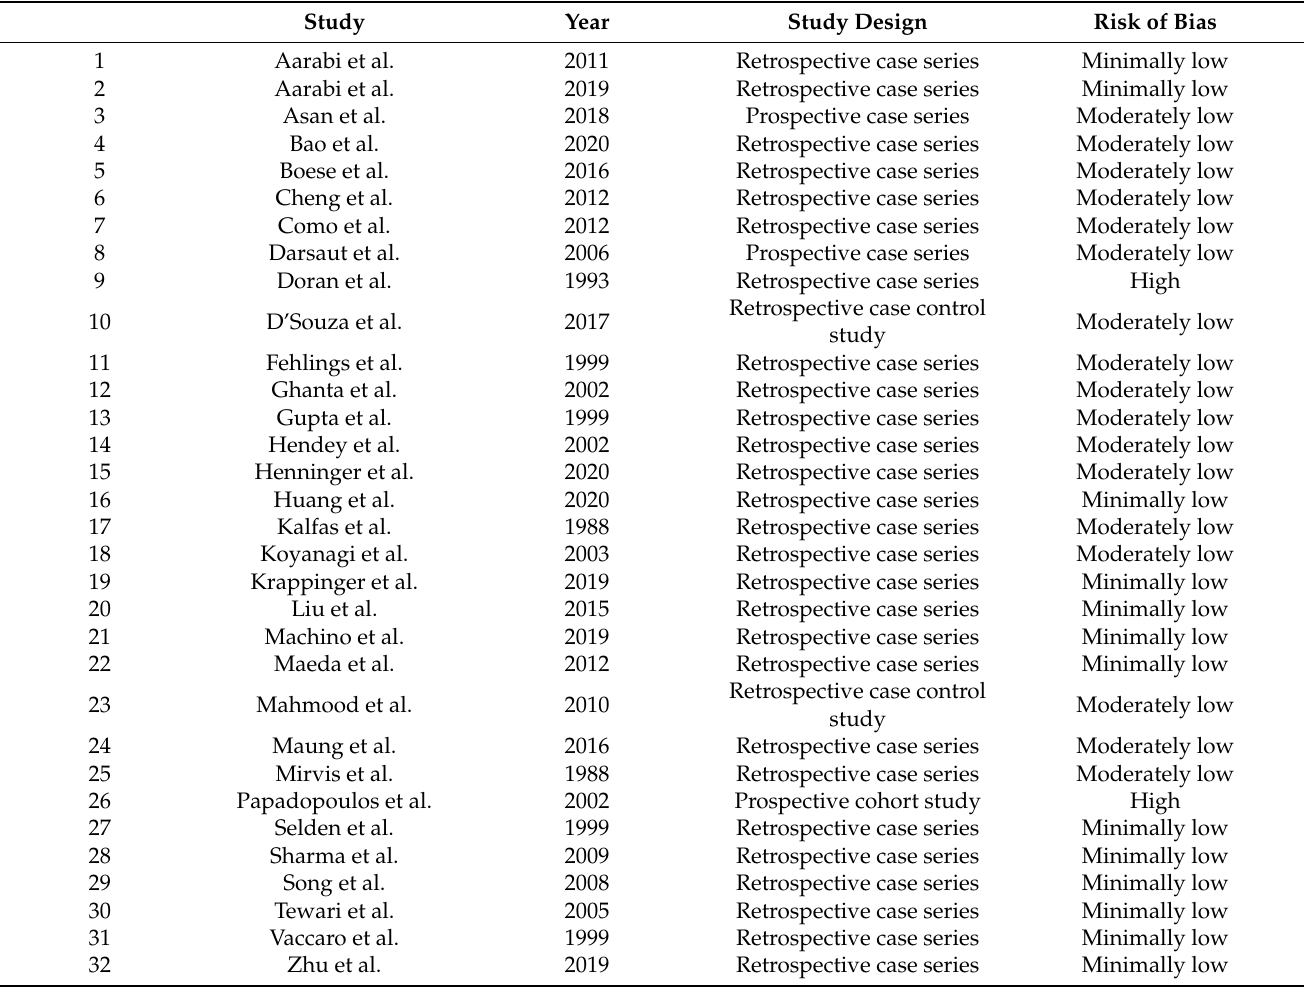
Table 9. Risk of bias assessment. Studies arranged alphabetically by the last name of the first author. Risk of bias assessment was performed according to the National Institutes of Health (NIH) Quality Assessment Tool. Studies appraised as good had minimally low risk of bias, studies appraised as fair had moderately low risk of bias, and those appraised as poor had high risk of